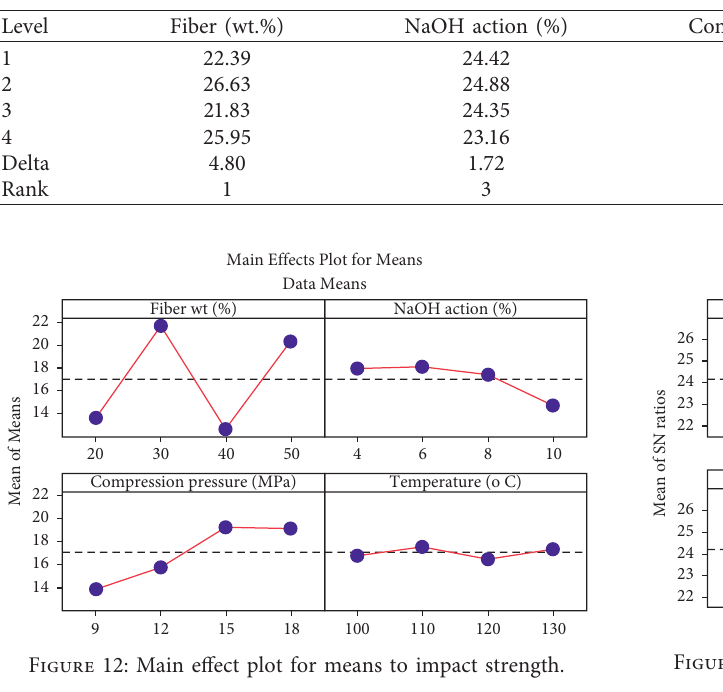
Table 7: Response table for signal-to-noise ratios (impact strength); larger is better.